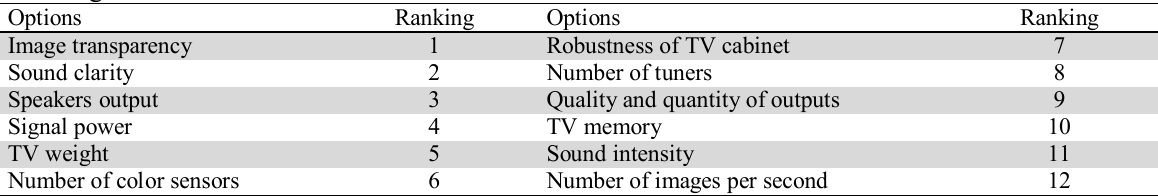
Ranking in the view of